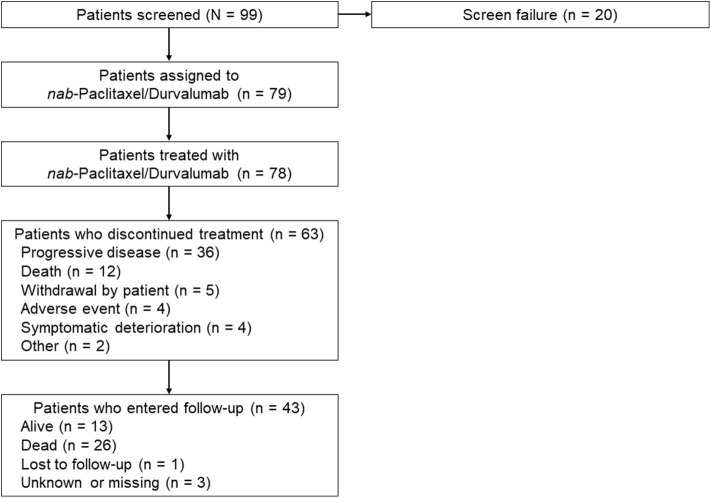
CONSORT diagram.